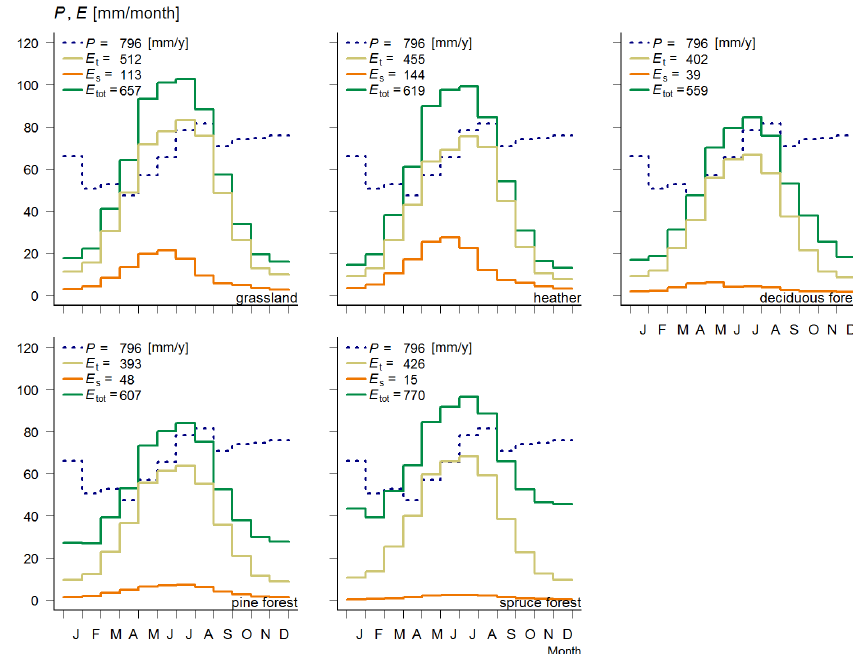
Figure 6. Illustration of synthetic “observed” potential evaporation components simulated with SWAP. The lines give monthly means over the period 1906–2013. E t and E s hold for a vegetation stand with a dry canopy only; E tot includes